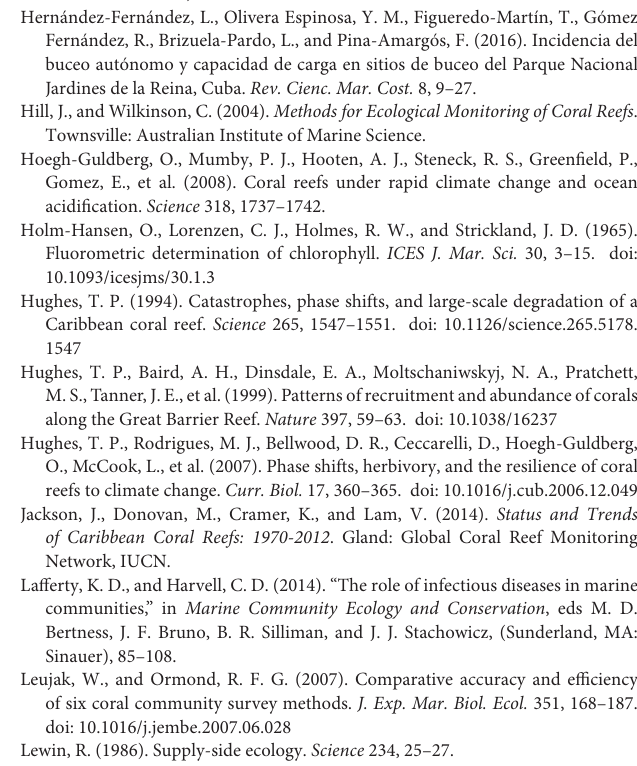
Figueredo, T. (2018). Influencia del gradiente de protección sobre el estado de las comunidades de corales y algas coralinas costrosas en el Parque